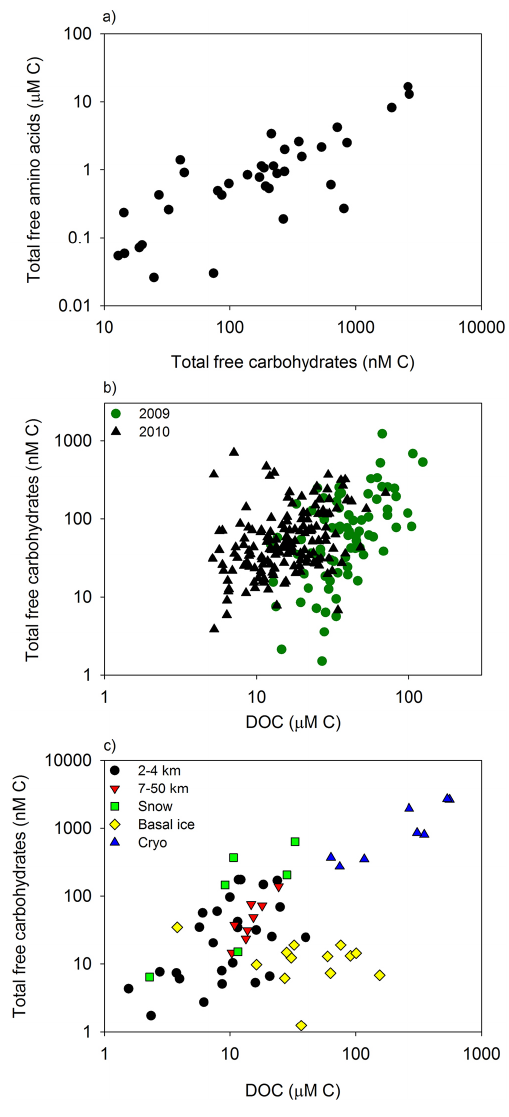
Figure 5. Comparisons of LMW-DOC compounds. (a) Free carbo- hydrates vs. free amino acids for a sample subset collected in 2010, (b) DOC vs. free carbohydrates in bulk runoff from 2009 and 2010, (c) DOC vs. free carbohydrates in basal ice and supraglacial melt samples (2009–2011). All data have been plotted on a logarithmic